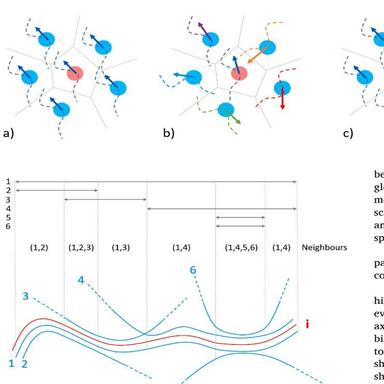
Concept representing length of neighbourhood (LON) for a 2D case. The neighbourhood of the reference fibre i (in red) varies through space, with fibres both approaching and leaving its vicinity. The local neighbourhood is indicated in brackets, while the arrows indicate the pairwise length of neighbourhood LPN between fibre i and each neighbour. (For interpretation of the references to colour in this figure legend, the reader is referred to the Web version of this article.)